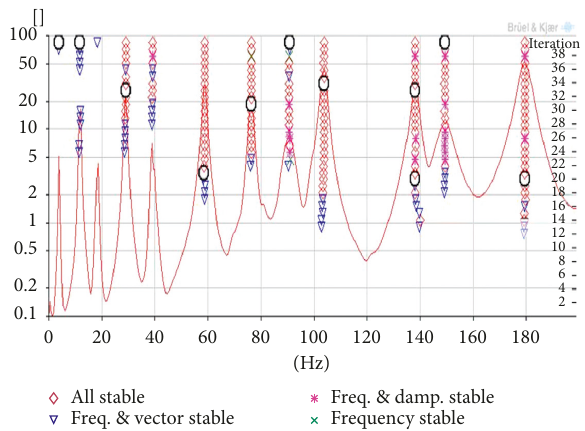
Figure 13: Stabilization diagram by the force hammer method.